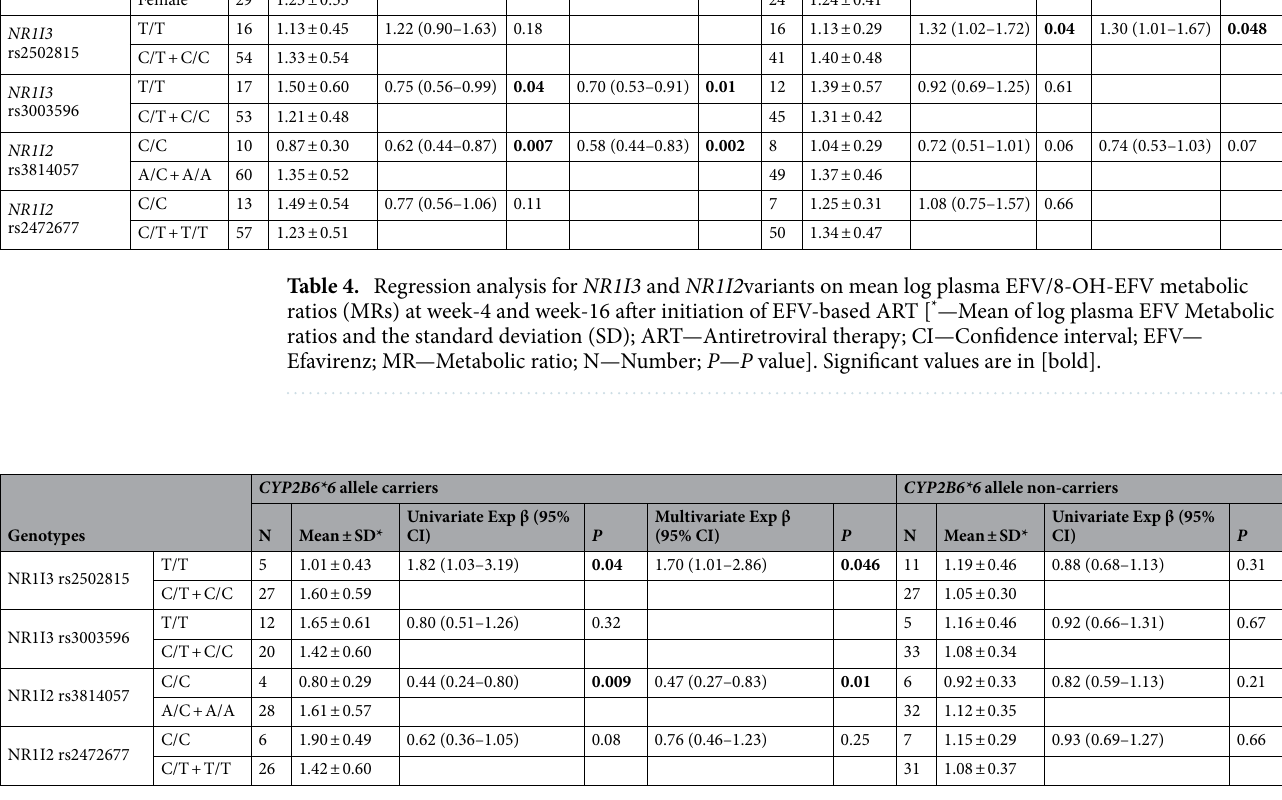
Table 5. Regression analysis for NR1I3 , NR1I2 variants on mean log EFV/8-OH-EFV metabolic ratios (MRs) at week-4 after initiation of EFV-based ART, stratified with CYP2B6*6 carrier status [ * —Mean of log plasma EFV Metabolic ratios and with the standard deviation (SD); ART—Antiretroviral therapy; CI—Confidence interval; EFV—Efavirenz; MR—Metabolic ratio; N—Number; P — P value]. Significant values are in